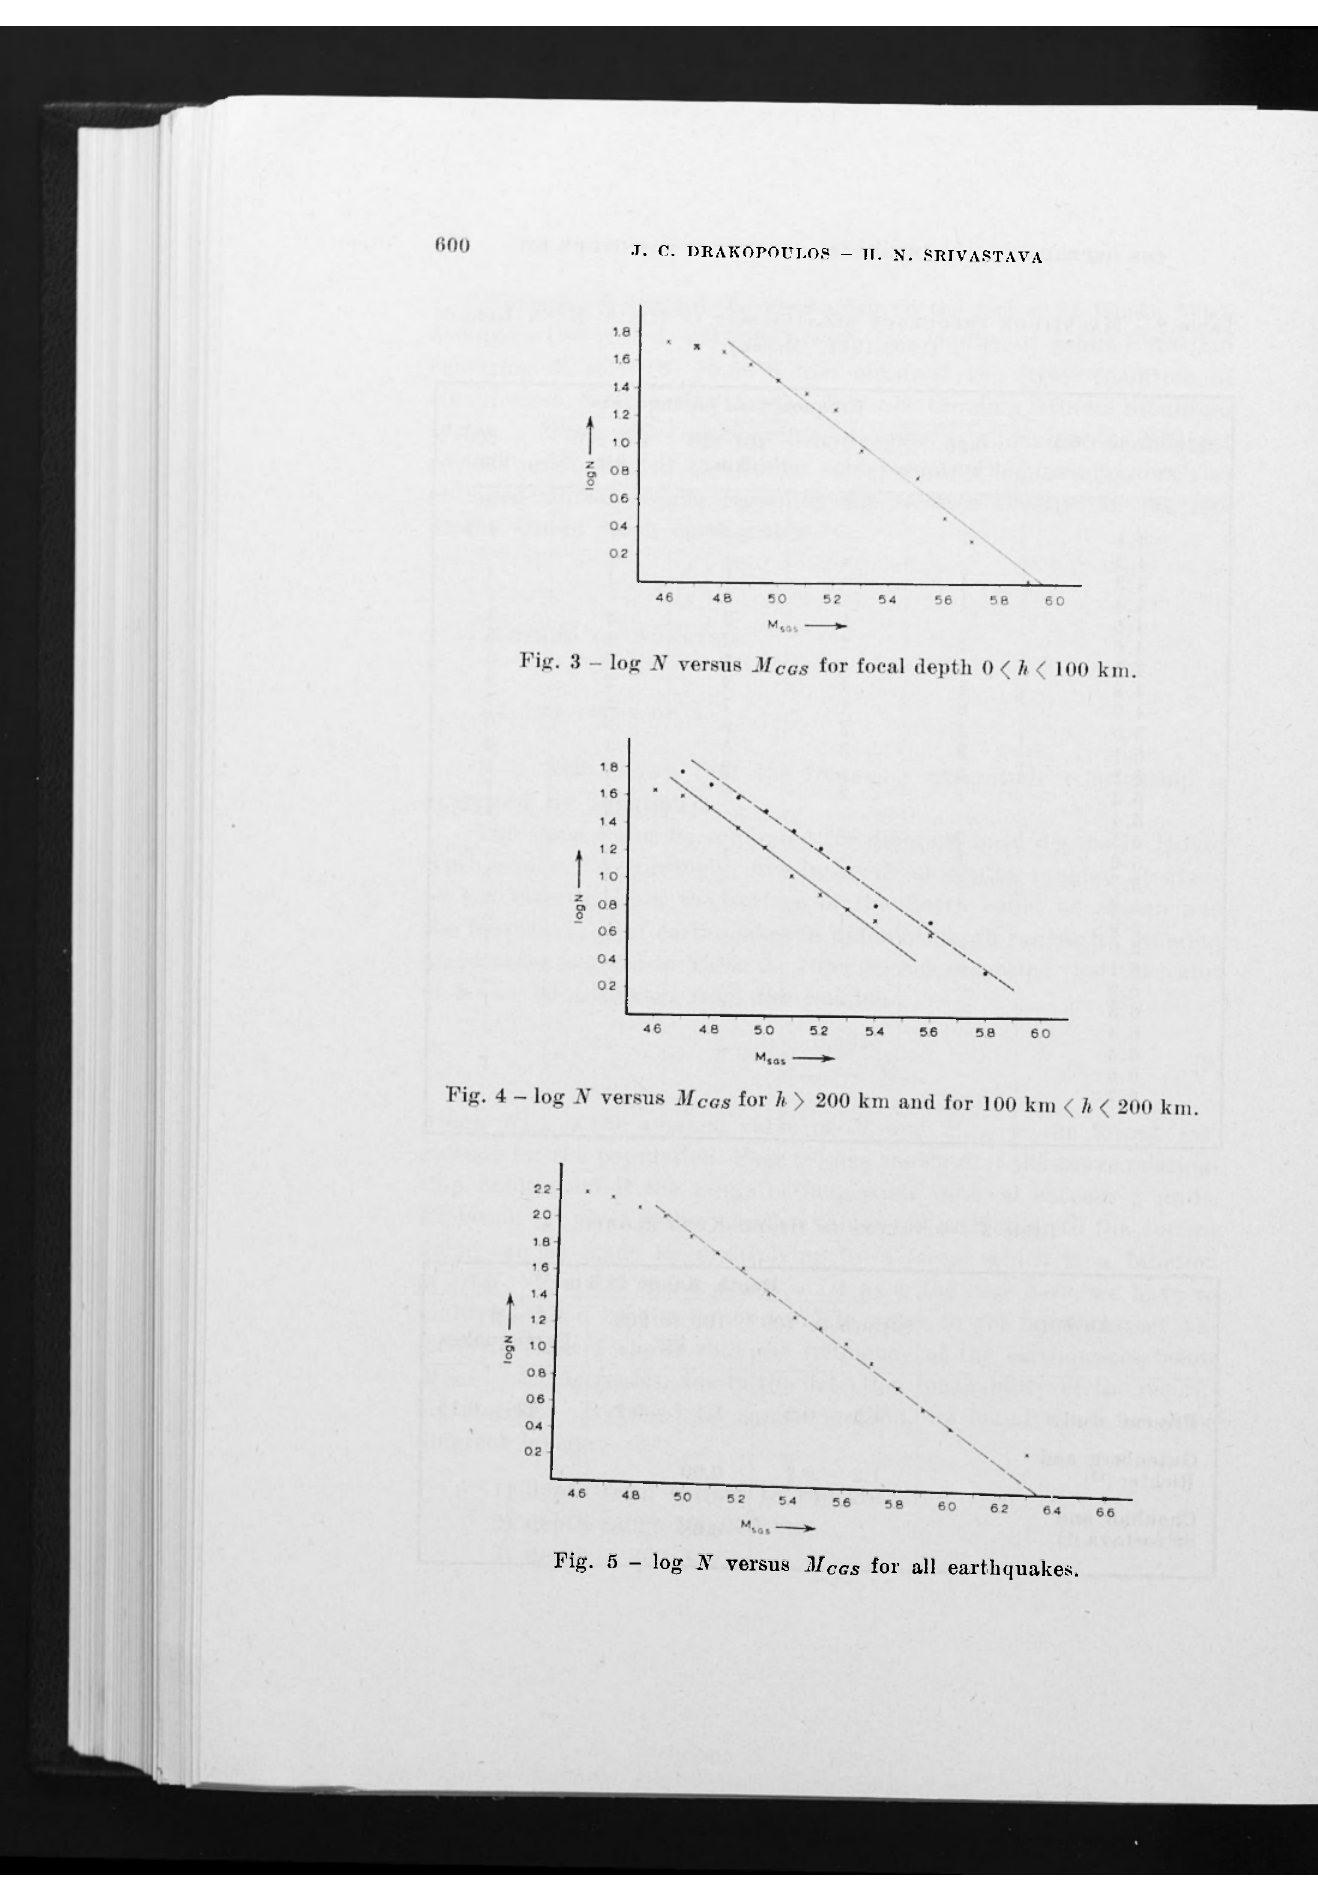
Fig. 5 - log N versus M C GS for all